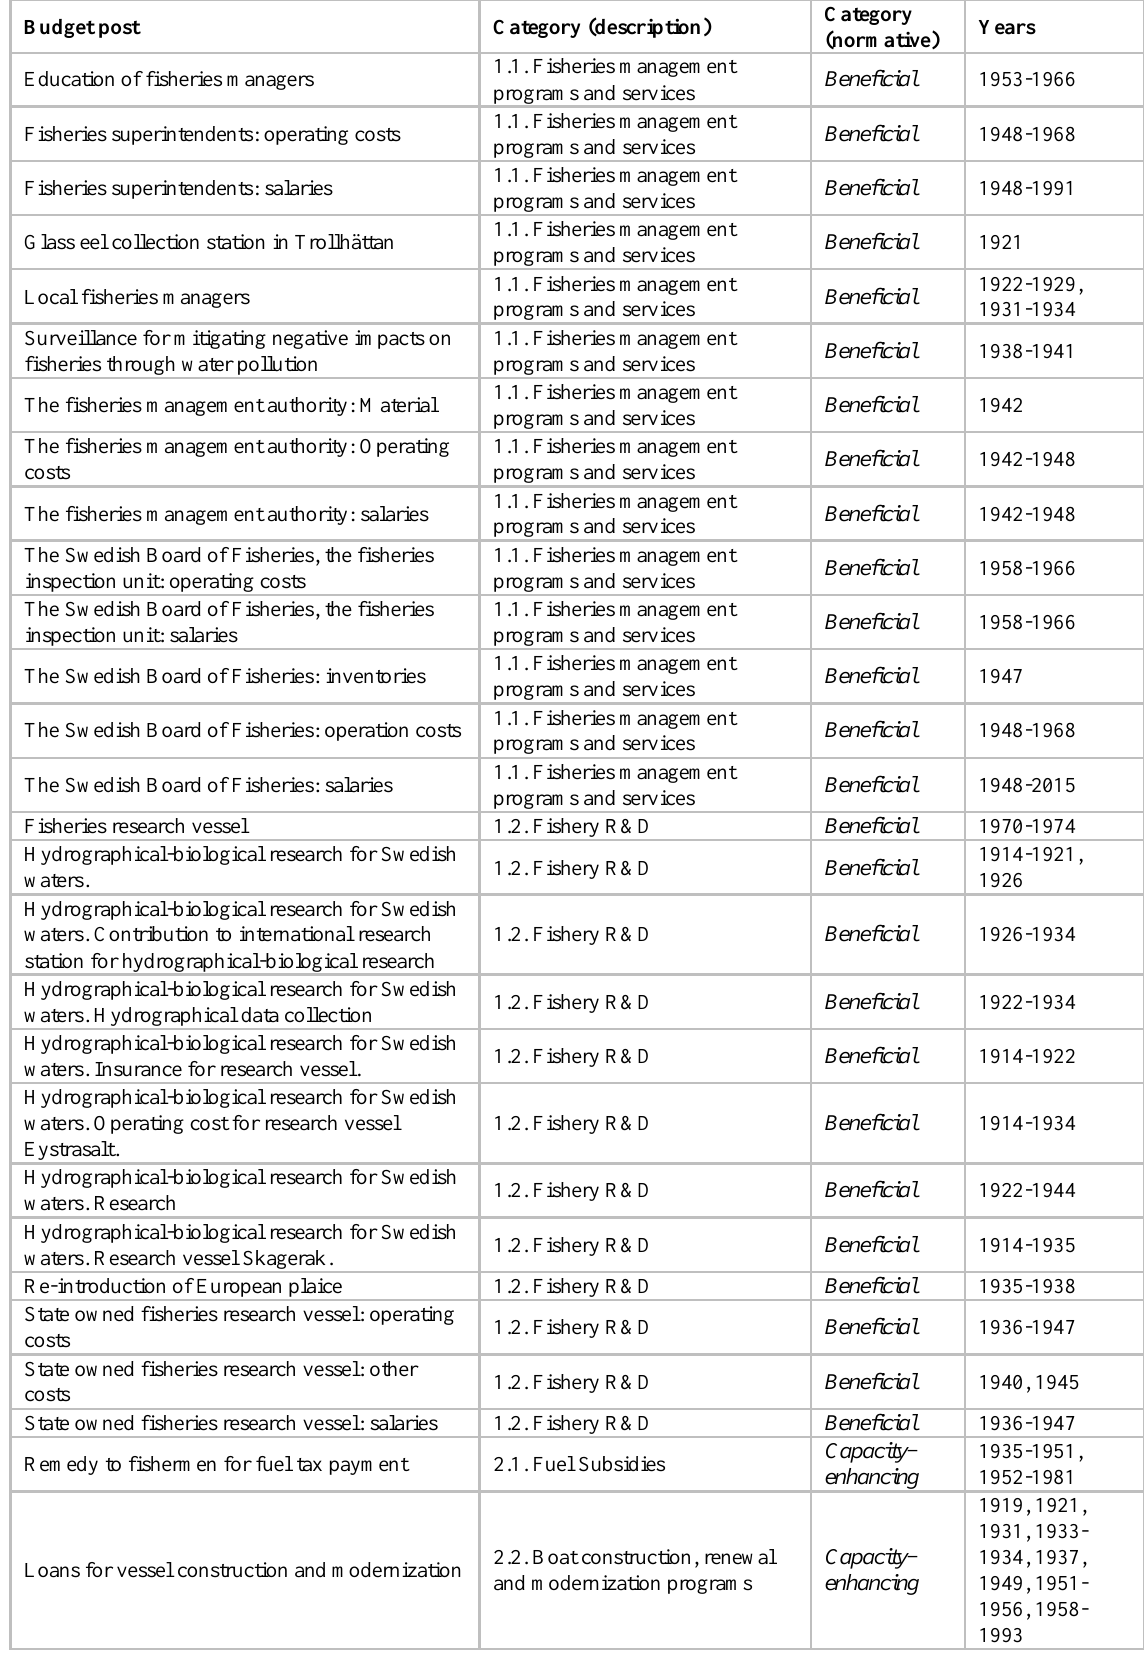
Table A1.2. All grants to the fishing industry and fisheries management as reported in the budget proposals for the Swedish government 1914-2015, their year of availability and their categorization into descriptive and normative categories according to Sumaila et al.